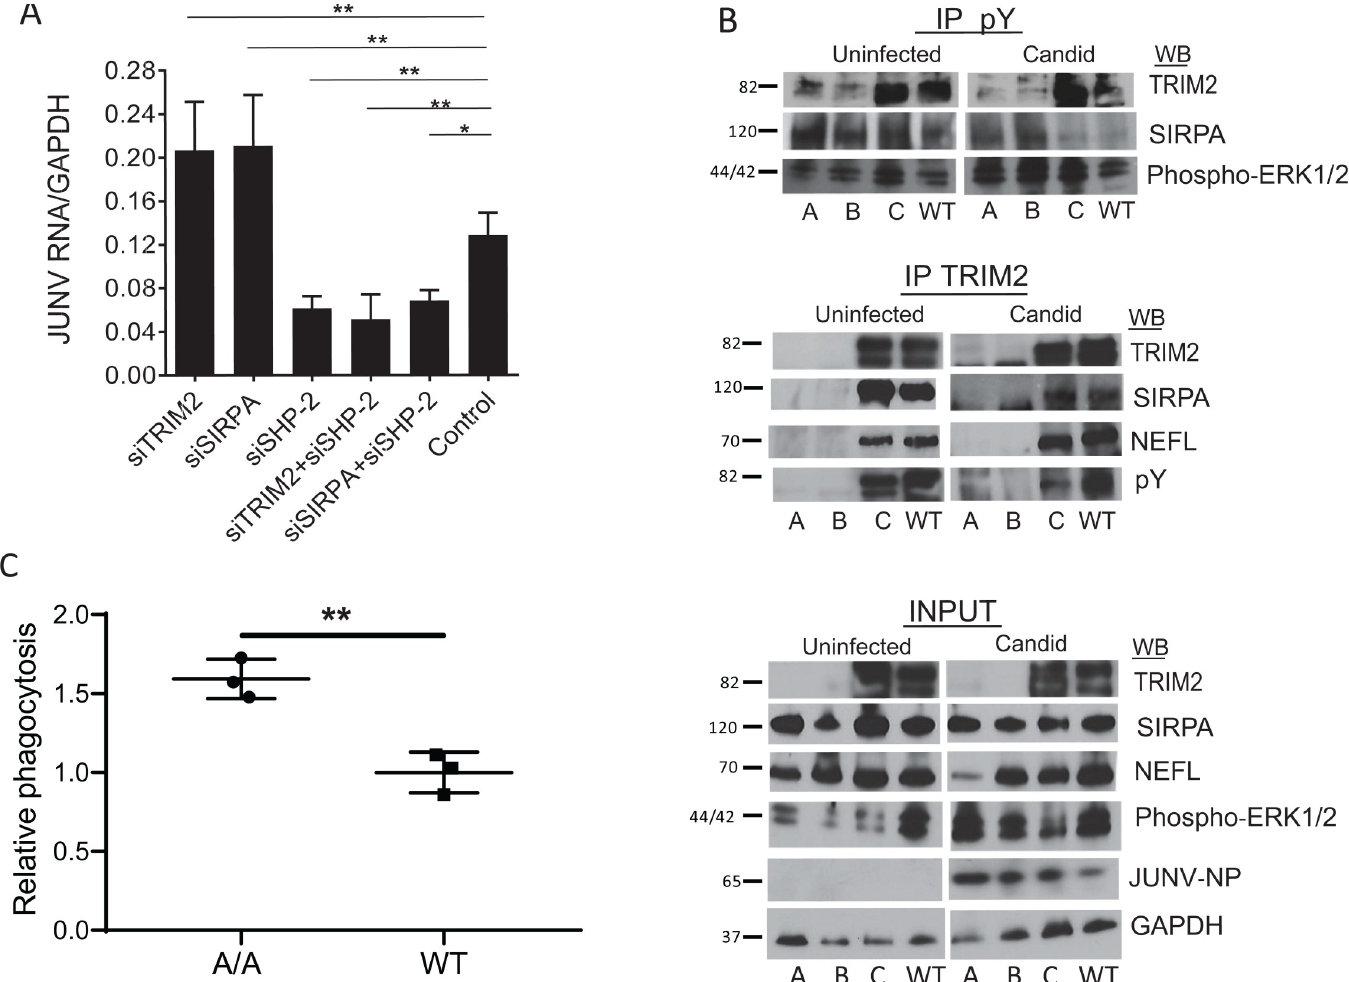
Fig 8. Role for SHP-2 in infection and TRIM2 in inhibition of phagocytosis. (A) U2OS cells were transfected with the indicated siRNAs and infected with Candid 1. Knockdowns of the RNAs are shown in S7B Fig. (B) Extracts from the brains of uninfected and Candid 1–infected mice were prepared and immunoprecipitated with anti- phosphotyrosine or anti-TRIM2 antisera and analyzed by WB with the indicated antibodies. (C) BMDMs isolated from 3 mice of each genotype were incubated with apoptotic phrodo Red–labeled thymocytes. Shown is the average percent internalization in CD11b+ cells for 3 experiments, normalized to WT in each experiment. Statistical significance was determined by unpaired t test. �� P � 0.005. Representative FACS plots are in S8 Fig. No difference was seen when BMDMs from either genotype were incubated with live thymocytes (S8 Fig). BMDM, bone marrow–derived macrophage; FACS, fluorescence-activated cell sorting; GAPDH, glyceraldehyde- 3-phosphate dehydrogenase; IP, immunoprecipitation; JUNV, Junı´n virus; NEFL, neurofilament light chain; NP, nucleoprotein; Phospho-ERK1/2, phosphorylated extracellular regulated kinase 1/2; siRNA, small interfering RNA; SIRPA, signal regulatory protein α ; WB, western blot; WT, wild